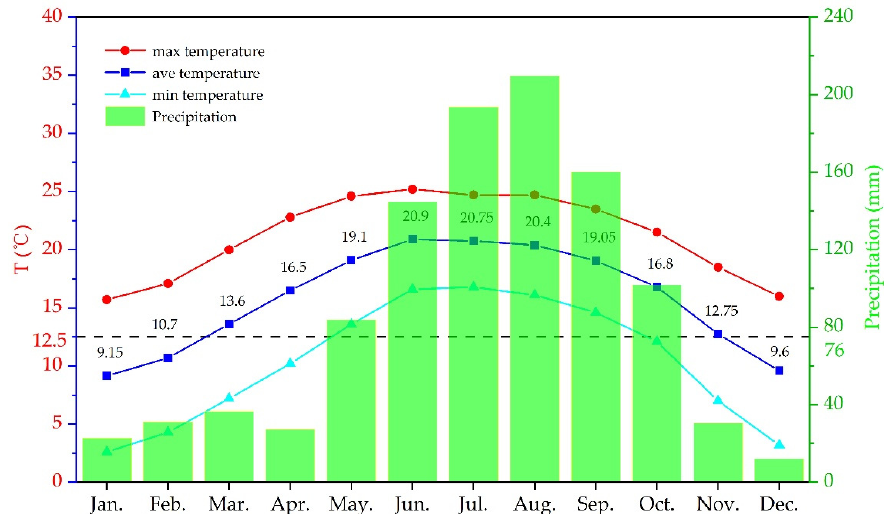
Figure 2. Monthly average temperature and precipitation from 1981 to 2010 (Dali Bai autonomous prefecture).